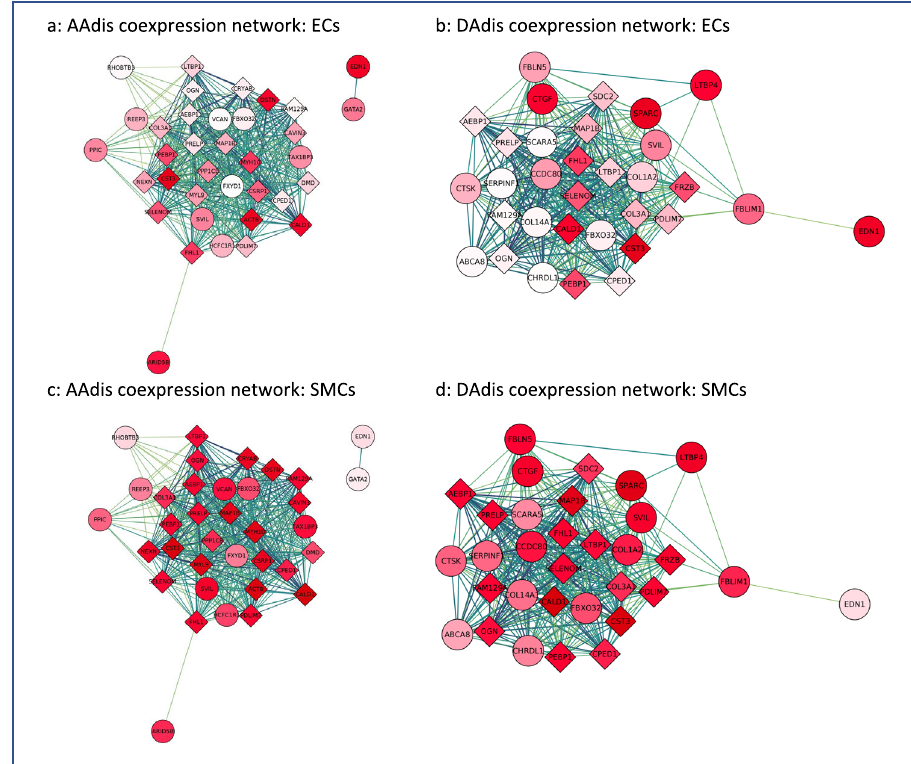
Fig.3|Co-expressionnetworksforaorticdistensibilityGWASgenesgenerated with primate single cell expression data for the aorta 42 . The co-expression networks were derived from extended models ( r >0.2) in aortic endothelial (ECs) and aortic smooth muscle cells (SMCs). Round circles represent genes which were signi fi cantly associated (unadjusted p value <5×10 − 8 ) with an aortic trait in the current GWAS. Diamonds represent other genes signi fi cantly co-expressed in the published single-cell data for the cell-type indicated. The deeper the shade of red, the higher the level of expression of that gene in the speci fi ed cell-type. The strength of co-expression is denoted by the colour of the lines joining genes with higher correlations indicatedby darker lines. “ Hub genes ” are found in the centres